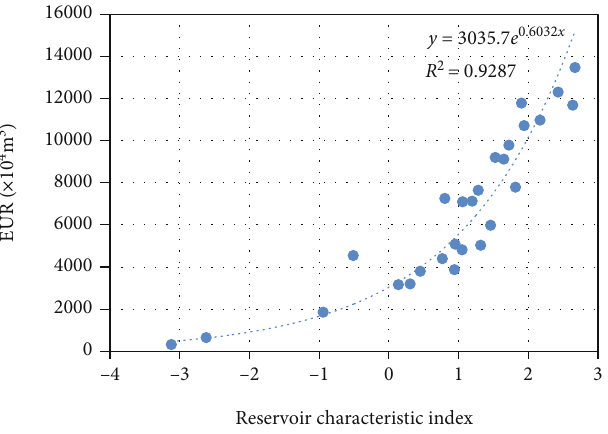
Figure 9: Plot of the reservoir characteristic index versus the EUR of wellblock